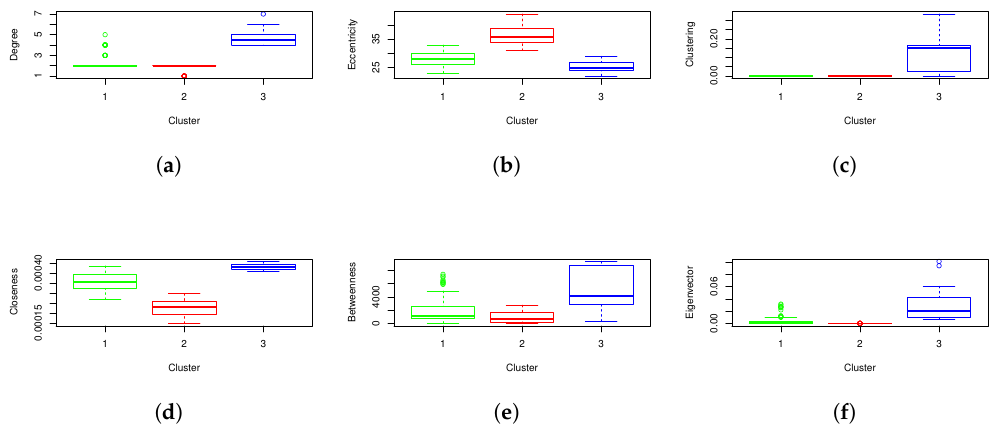
Figure 8. Centrality measures boxplots. ( a ) Degree; ( b ) Eccentricity; ( c ) Clustering; ( d ) Closeness; ( e ) Betweenness; ( f ) Eigenvector Centrality.